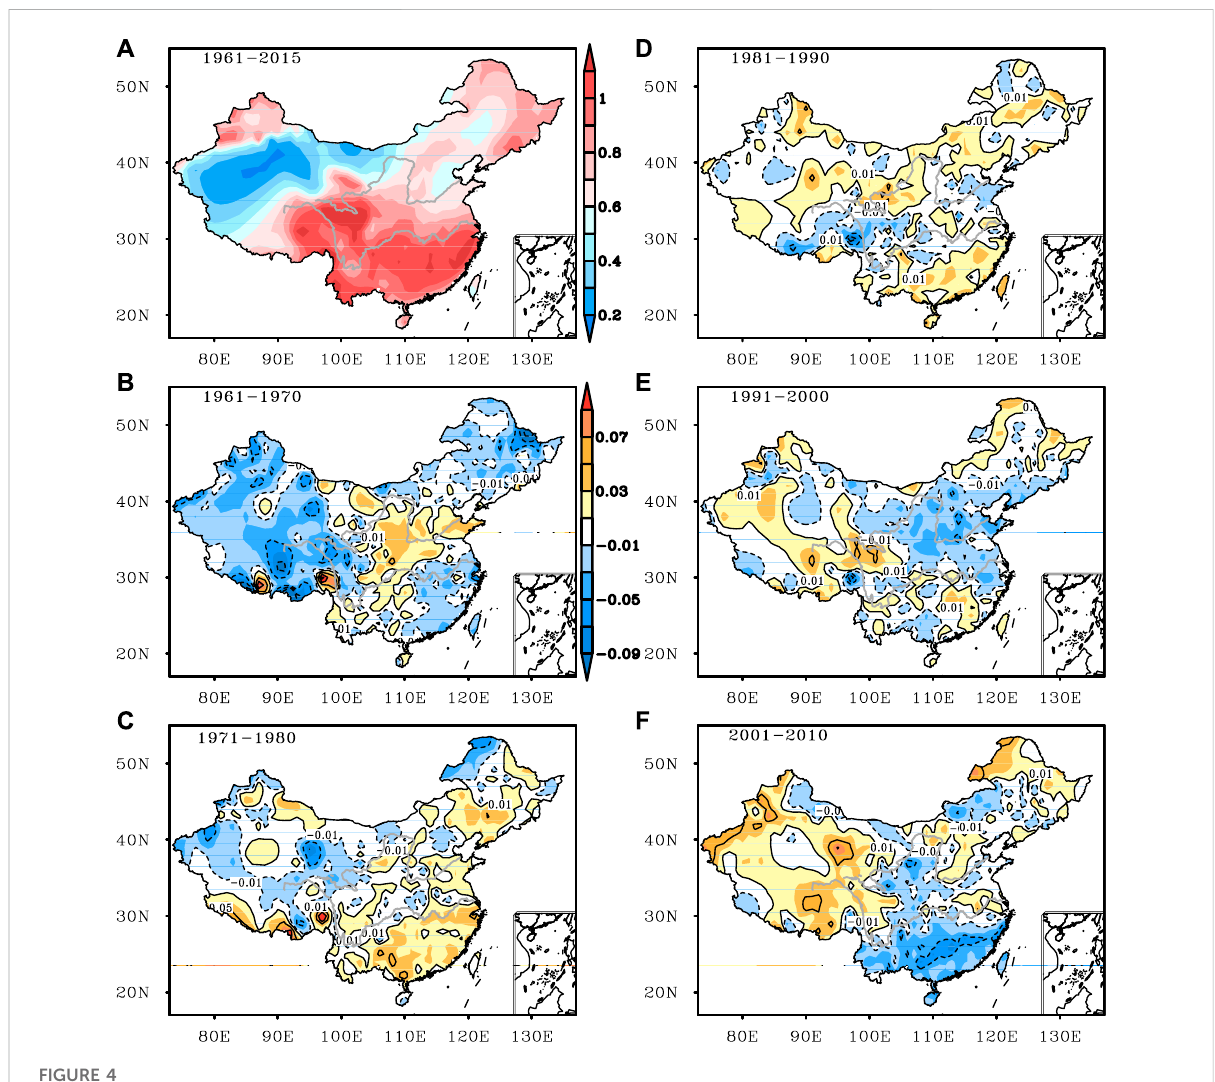
FIGURE 4 ApEn of daily precipitation in China during (A) 1961 – 2015 and the ApEn anomaly of daily precipitation in China during (B) 1961 – 1970, (C) 1971 − 1980, (D) 1981 − 1990, (E) 1991 − 2000, and (F) 2001 −